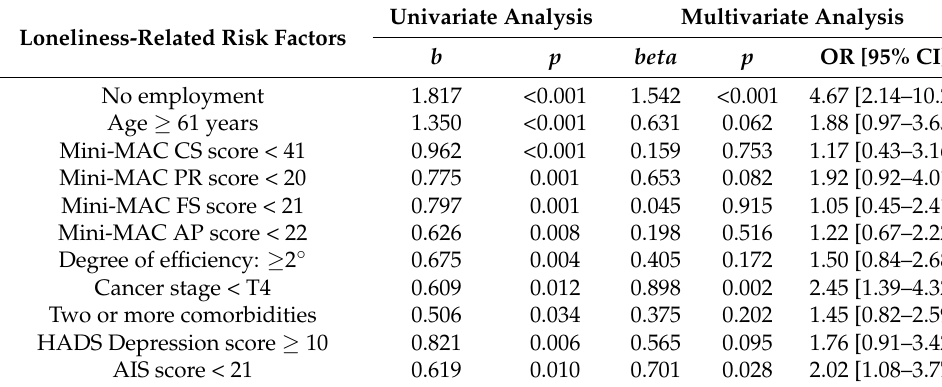
Table 4. Results of univariate and multivariate logistic regression analysis. Univariate Loneliness-Related Risk Factors